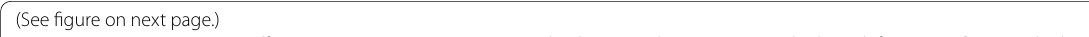
Fig. 6 Comparison to in situ offset measurements in Kumamoto (Shirahama et al. 2016). a Unmasked EW deformation. b Unmasked NS deformation. c Horizontal offsets of the field survey and SAR-derived deformation, and their difference. d Unmasked UD deformation. e Vertical offsets of the field survey and SAR-derived deformation, and their difference. Black cross marks in a , b and d denote the in situ measurement locations. Semi-transparent points in c and e are on the masked pixels in the SAR-derived deformation. The masked SAR-derived deformation is depicted in Additional file 1: